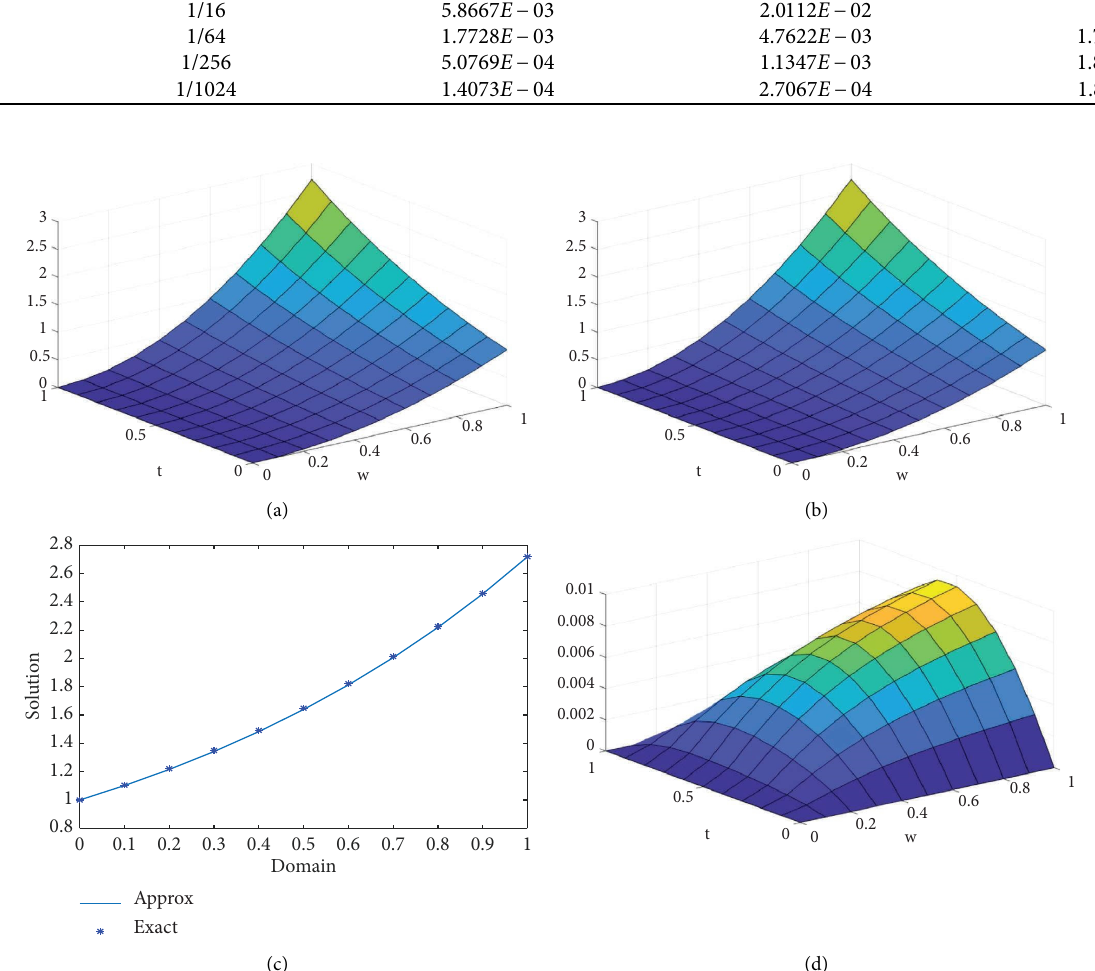
Figure 1: Solution profle of approximate, exact, and error of Y at h � Δ t � 0 . 1 , α (b) Exact solution. (c) Approximate vs Exact. (d) Error.